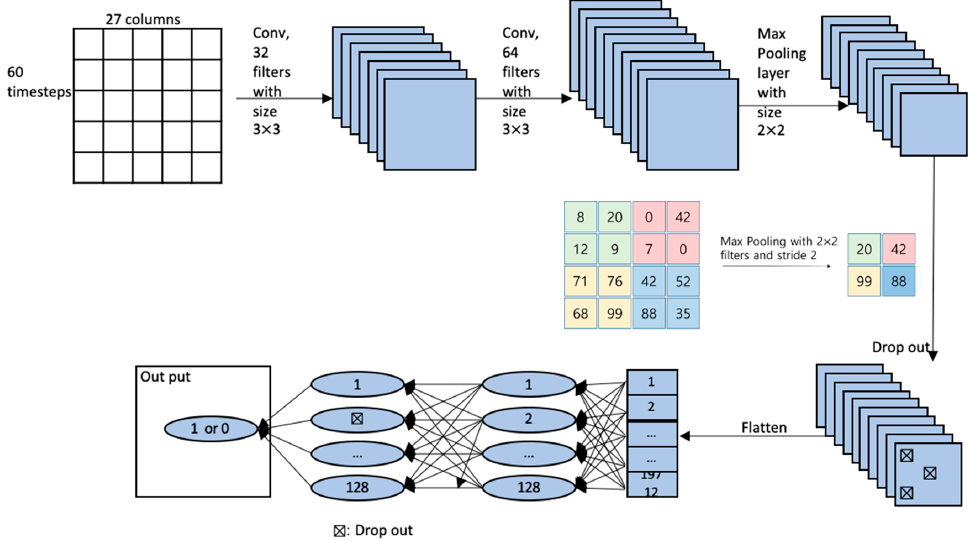
Figure 4. CNN architecture and vital record processing for CNN.